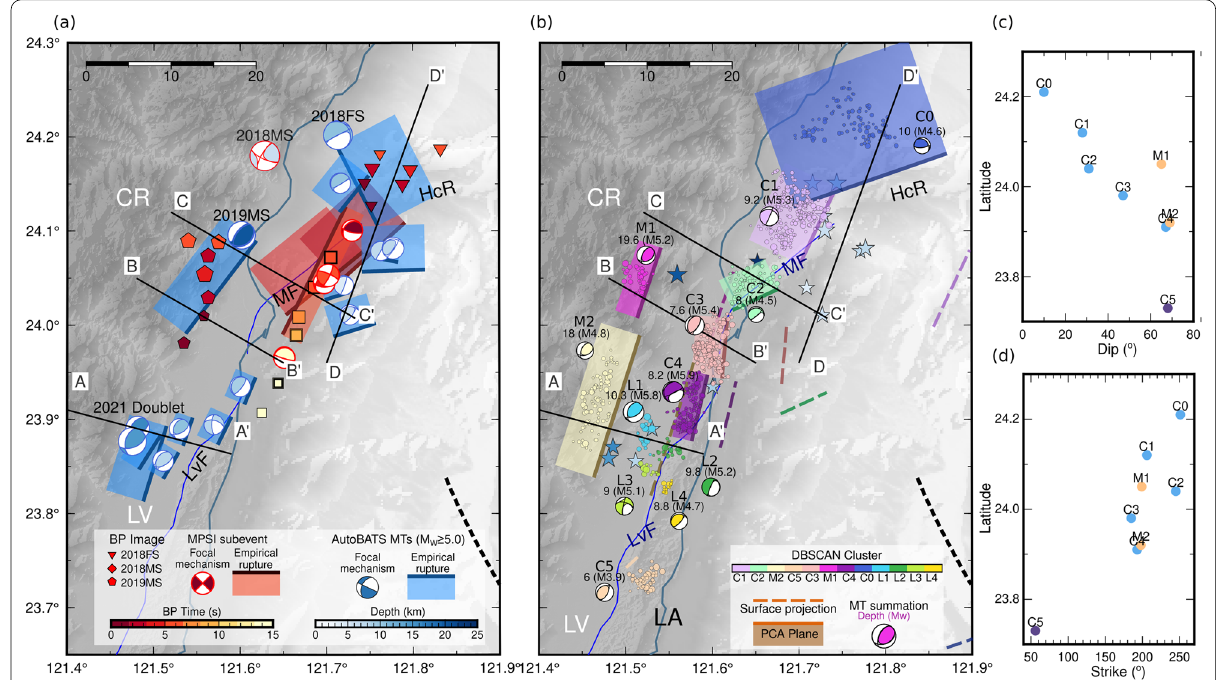
Fig. 6 Rupture zones summarized by empirical ruptures associated with larger events (M W 5.0) and DBSCAN and PCA results: a geometries of ≥ empirical rupture planes based on AutoBATS MT solutions, where coloring of beach balls indicates focal depth, rupture lengths are derived from M W based on empirical relation, and aspect ratio was wet at 0.75 to estimate rupture width, BP imaging results of 2018FS, 2018MS, and 2019MS are presented as reference, and red to orange color bar indicates formation of rupture propagation; b DBSCAN and PCA results with cluster events (circles), corresponding PCA planes (rectangles), and larger earthquakes (stars) (note the number of cluster events did not meet our threshold (25) for clusters L1–L4, and MT summations for each cluster are presented beside PCA planes); c , d dip and strike angles of PCA planes respective to